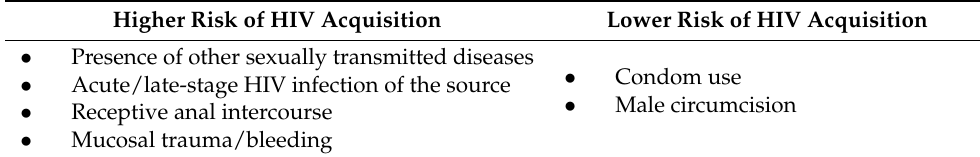
Table 2. Factors influencing the risk of HIV transmission during sexual exposure according to CDC guidelines [27].